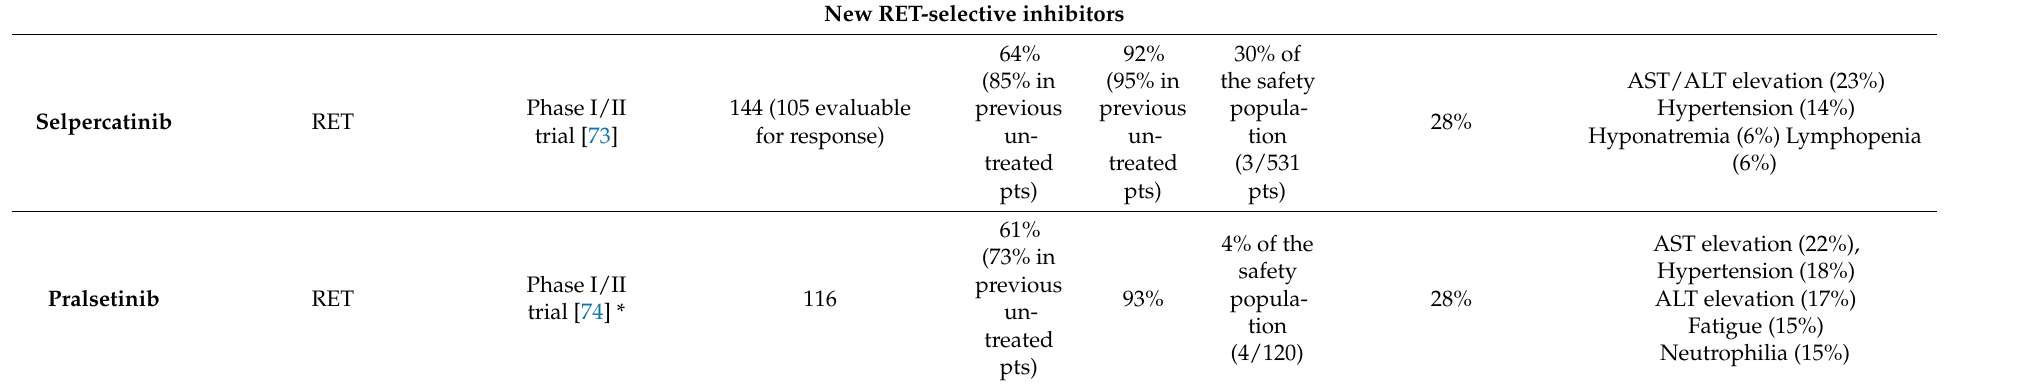
Table 2. Cont. New RET-selective